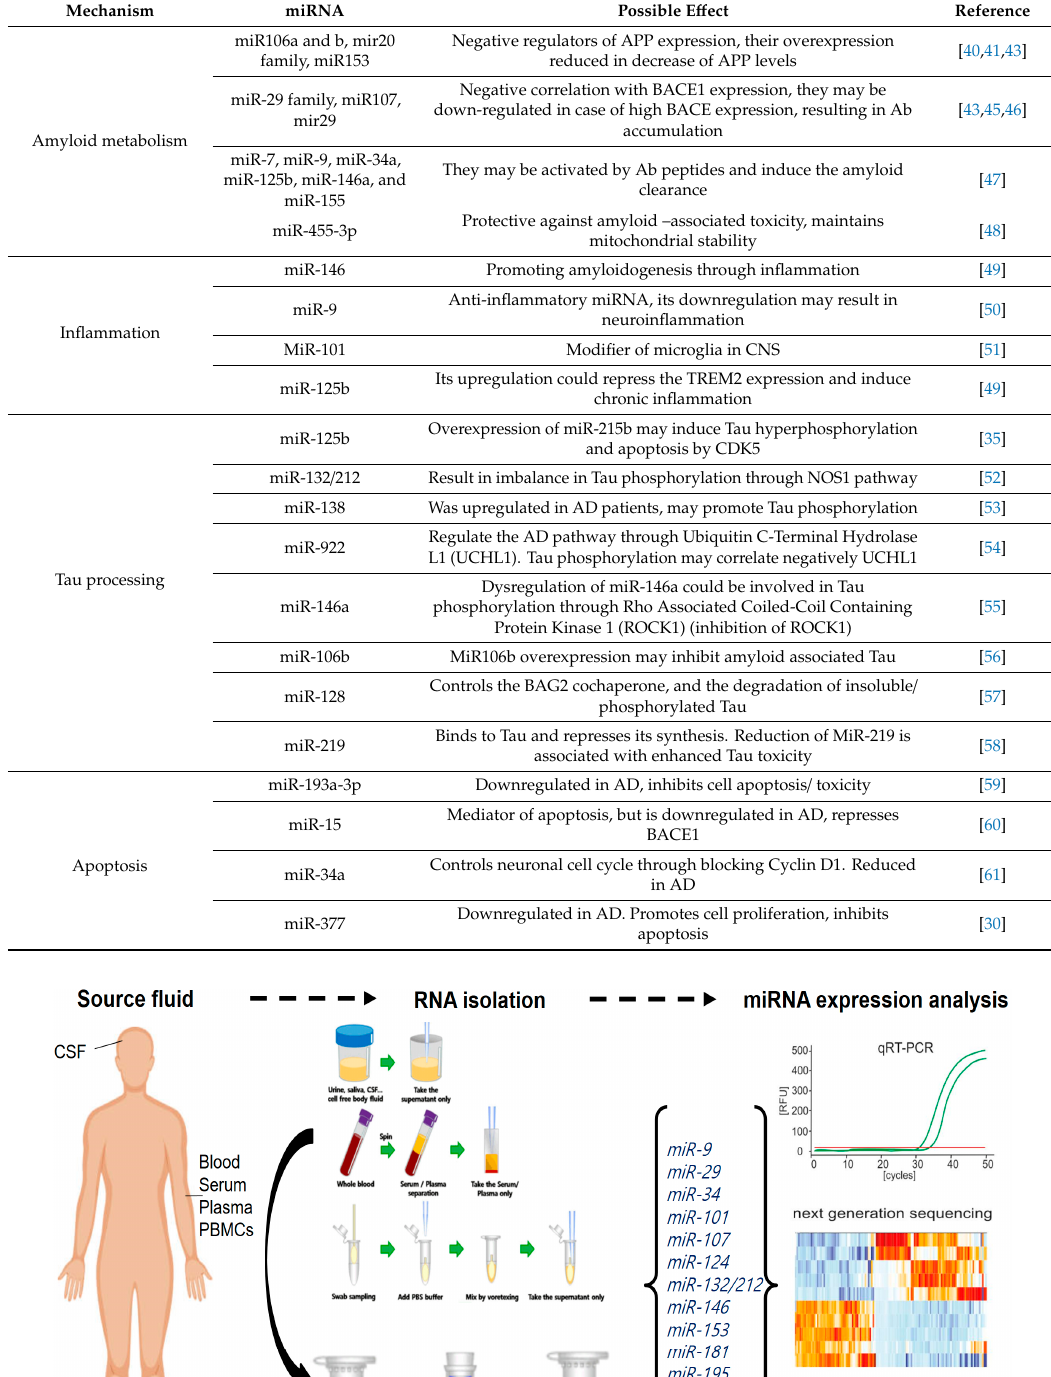
Table 1. Examples on miRNAs involved in Alzheimer’s disease (AD).